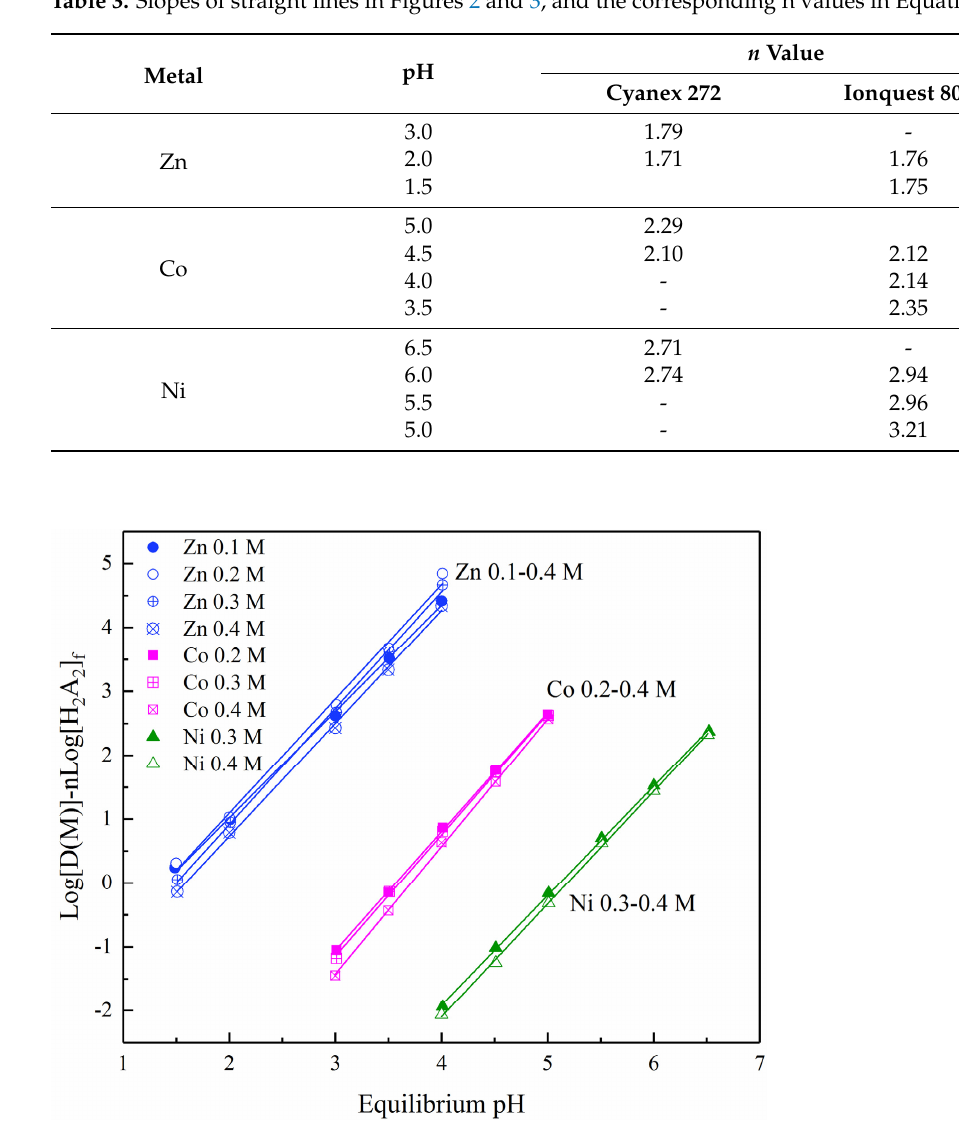
Figure 4. The linear relationship of Log D(M)-nLog [H 2 A 2 ] f and equilibrium pH for the metal extraction with Cyanex 272.